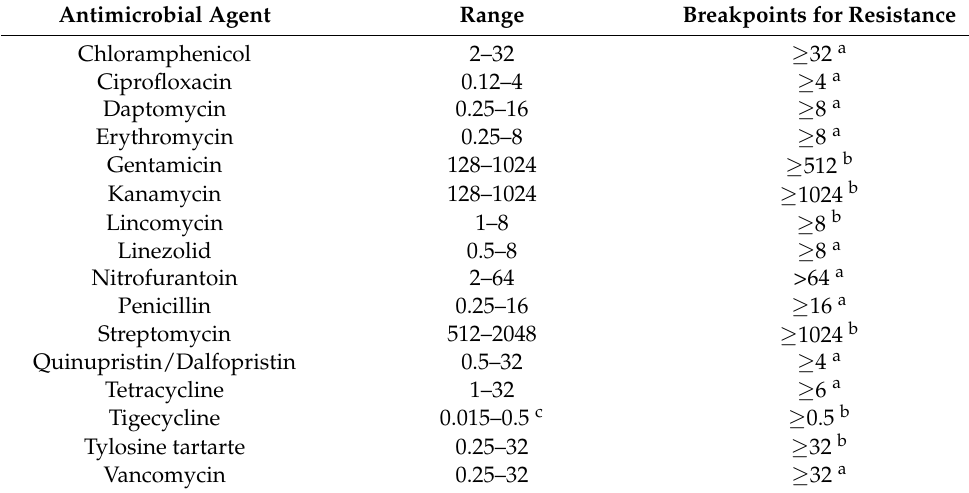
Table 1. Dilution ranges and breakpoints used for antimicrobial susceptibility testing of Enterococcus isolates of faecal origin. Antimicrobial Agent Range Breakpoints for